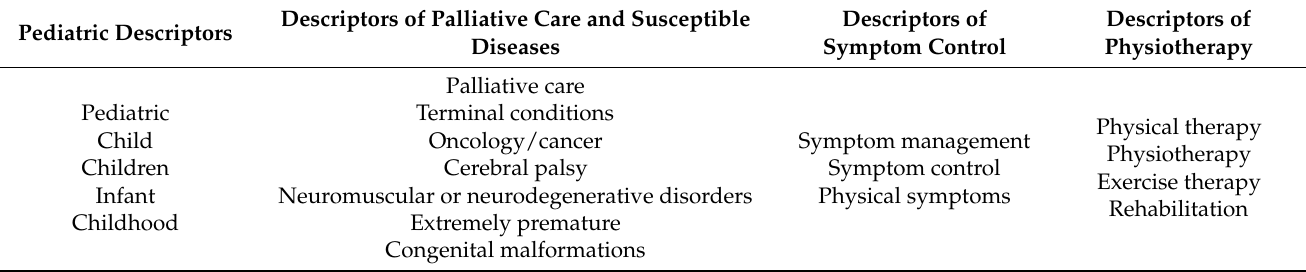
Table 2. Search strategy of studies on the role of physiotherapy in PPC. Pediatric